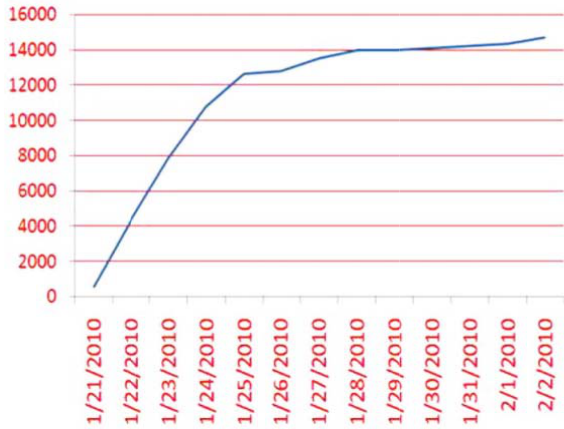
Figure 17: Fr damage grad volunteers, by weeks after t